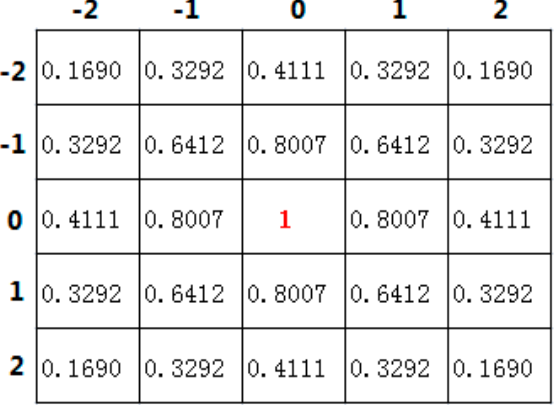
Figure 3. Distribution of the orientation weight in Cartesian coordinates.